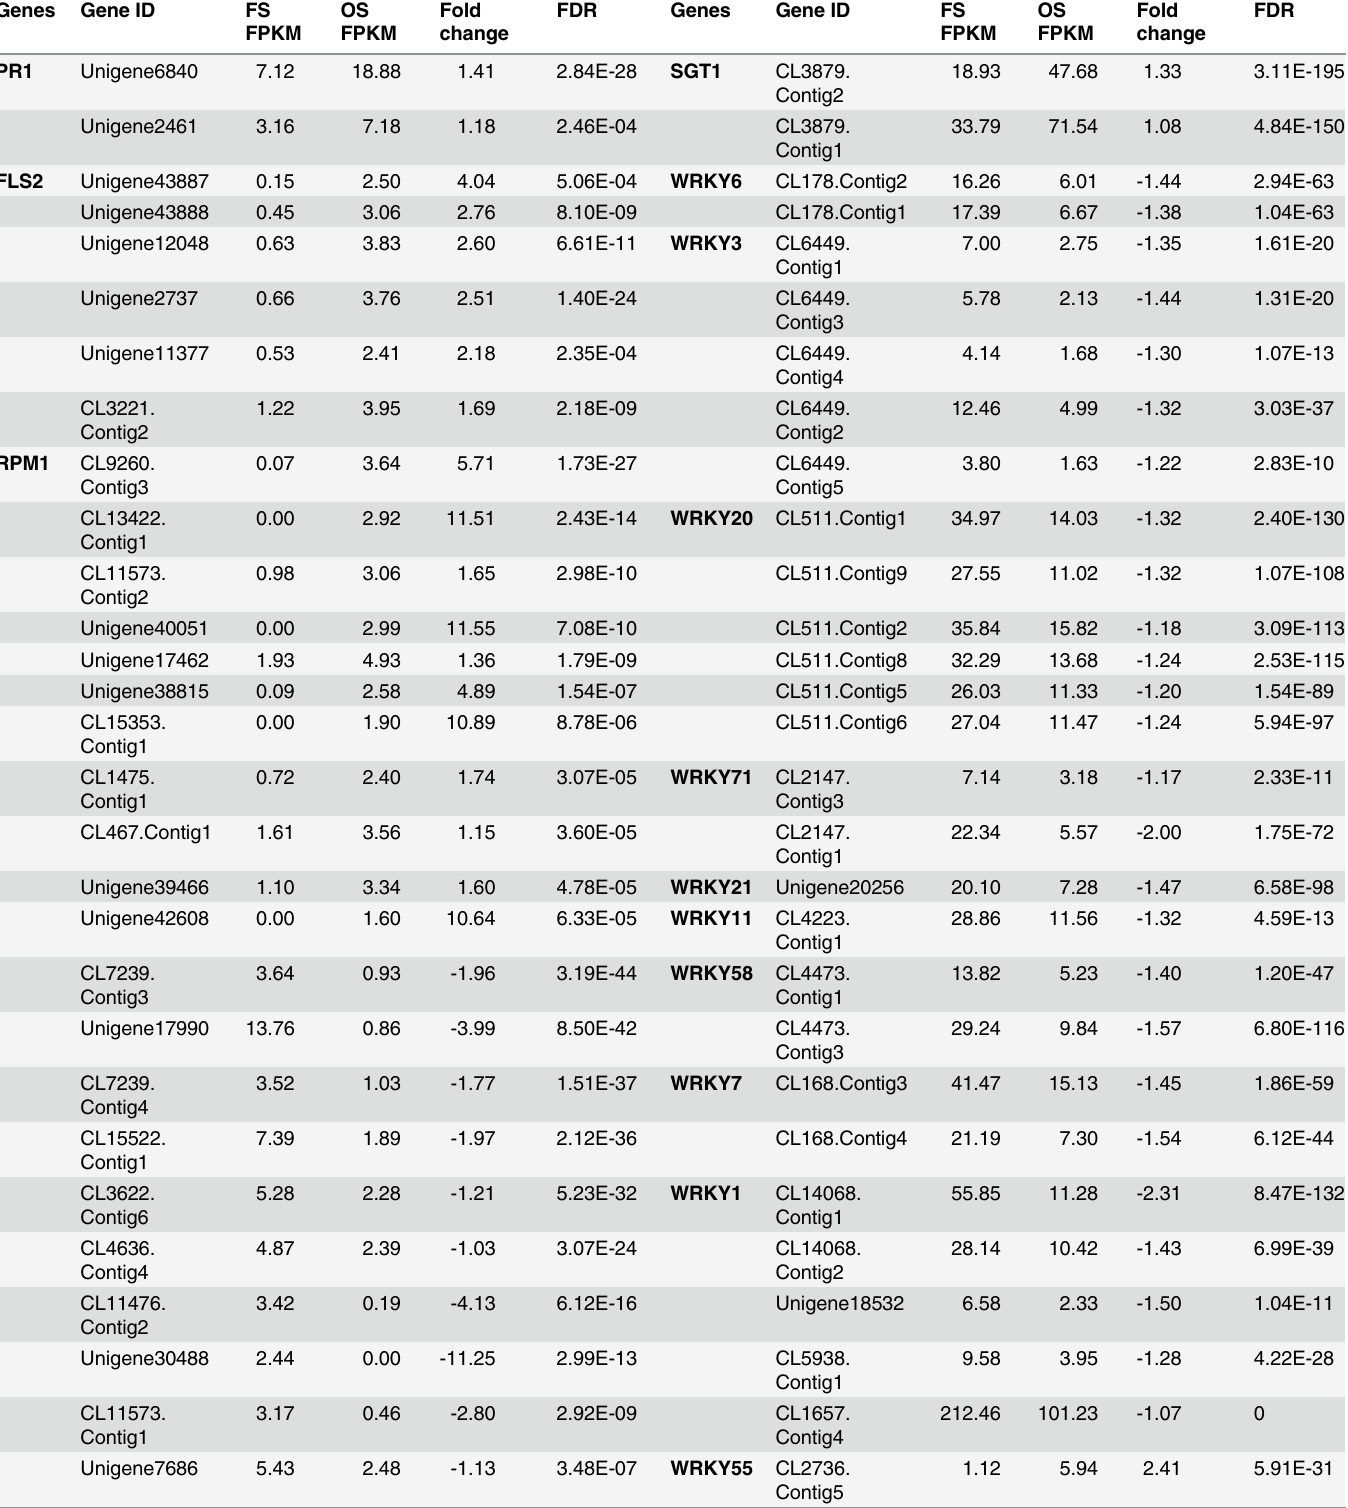
Table 4. The DEGs related to